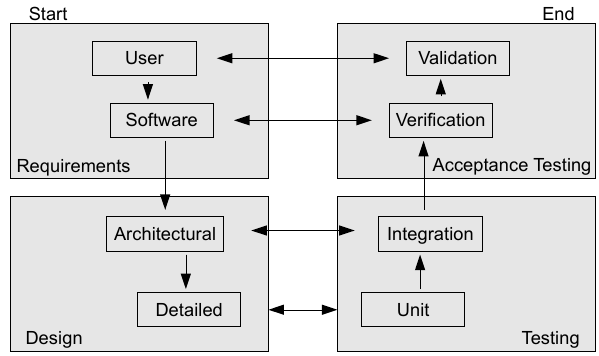
Fig. 1. Illustration of a typical “waterfall” type of software life- cycle. The work-flow is through the stages down the left side and back up the right side. The horizontal arrows indicate interde- pendencies between stages, e.g. the integration tests are designed demonstrate that each architectural design feature has been imple- mented